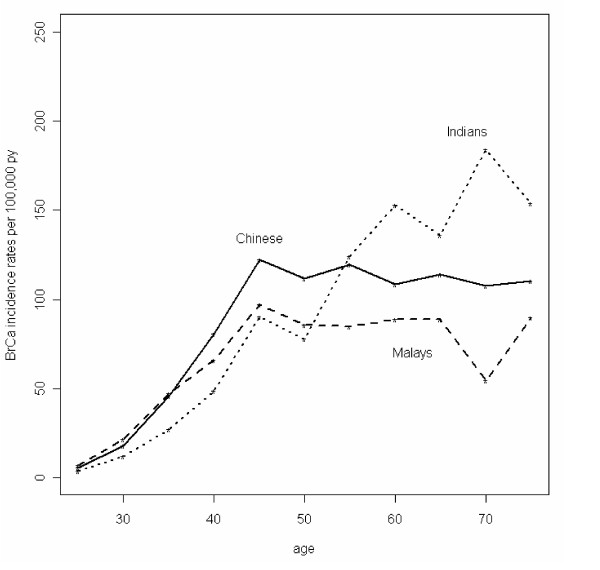
Overall age-specific breast cancer rates stratified by ethnicity and 5-yearly diagnosis period from 1968 – 2002 (as indicated by the first year of the 5-yearly intervals).